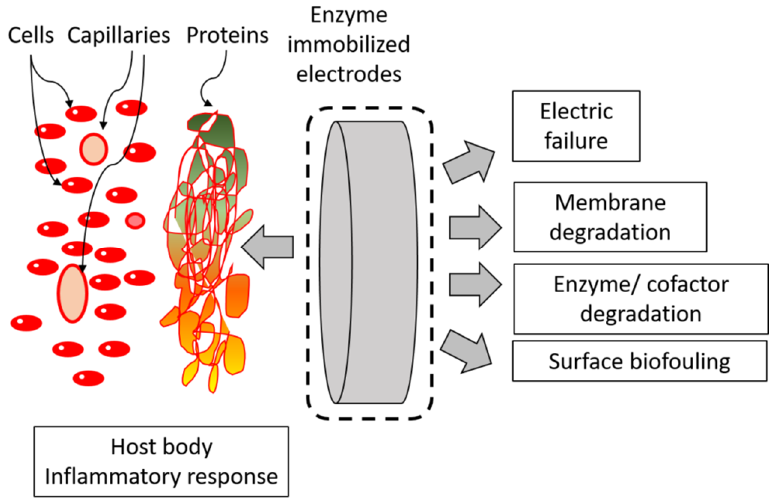
Figure 12. Common reasons for implanted EBFC failures.